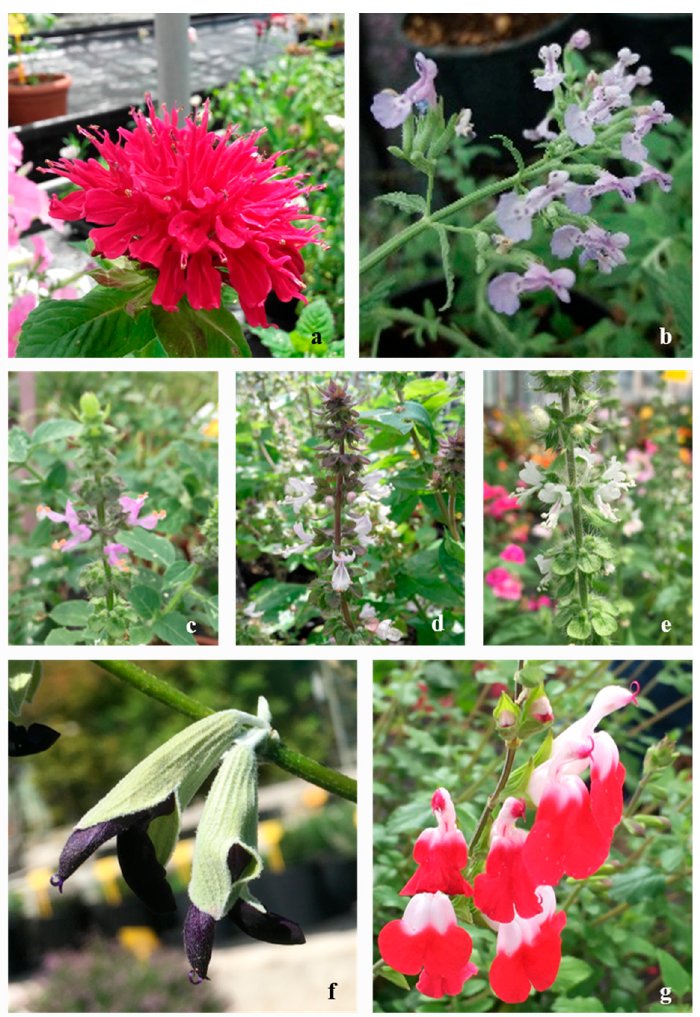
Figure 1. Selected flowers belonging to Lamiaceae family: ( a ) Monarda didyma ‘Fireball’ (M. did), ( b ) Nepeta × faassenii “Six Hills Giant” (N. × faas), ( c ) Ocimum basilicum ‘Blue Spice’ (Ob-BS), ( d ) O. basilicum ‘Cinnamon’ (Ob-Cn), ( e ) Ocimum × citriodorum (Ob-Ct), ( f ) Salvia discolor (S. disc), ( g ) Salvia microphylla ‘Hot Lips’ (S. micro). Table 1. Main botanical information of the examined Lamiaceae flowers. * = The taste was evaluated by CREA (Research Centre for Vegetable and Ornamental Crops, Sanremo, IT) and CREAM (Chambre d’Agriculture des Alpes-Maritimes, Nice, FR), as one of the ANTEA project goals.